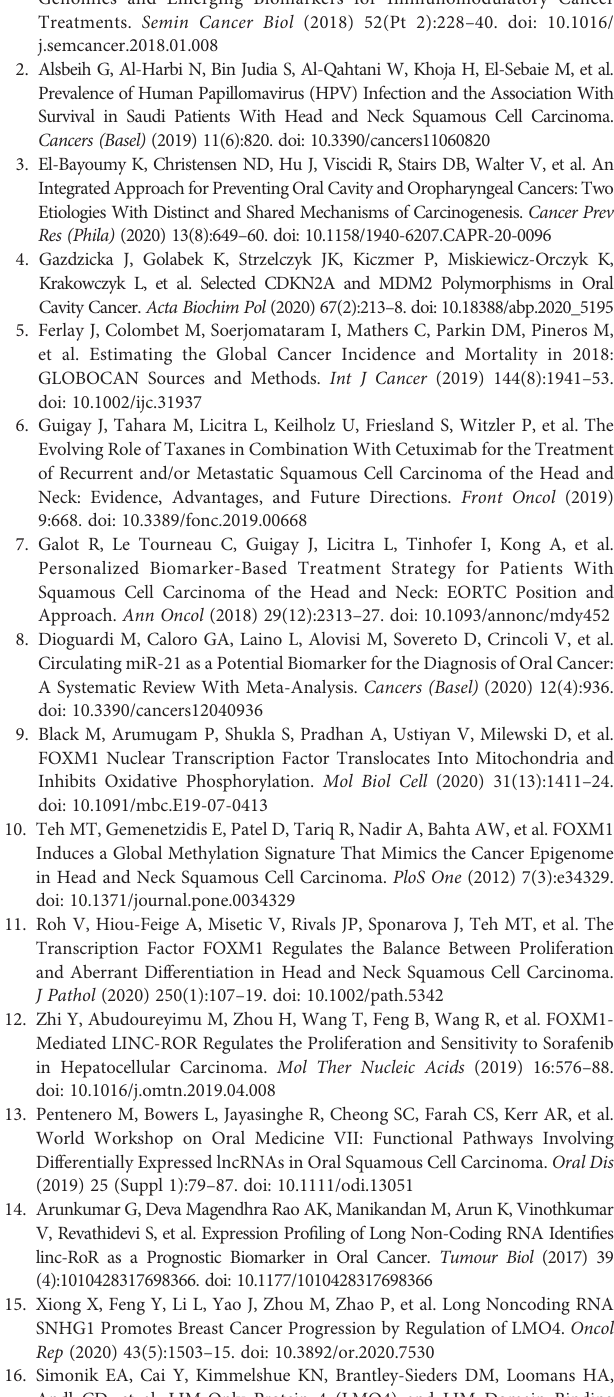
Supplementary Figure 1 | FOXM1 bound to the promoter of Linc-ROR according to the UCSC genome database (gene assembly version hg19, DNA range: chr18: 54,729,703-54,747,249).